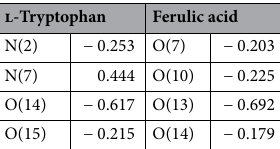
Table 9. Extended Huckel charges for nitrogen and oxygen atoms in l-Tryptophan and Ferulic